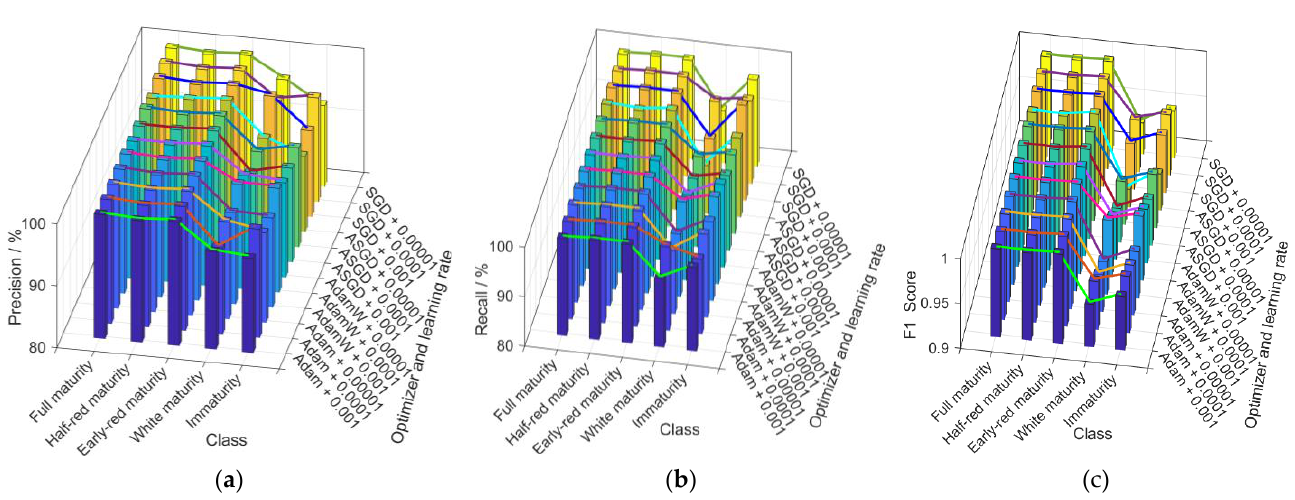
Figure 7. Results for each maturity using different learning rates and optimizers: ( a ) precision; ( b ) recall; ( c ) F1 score.